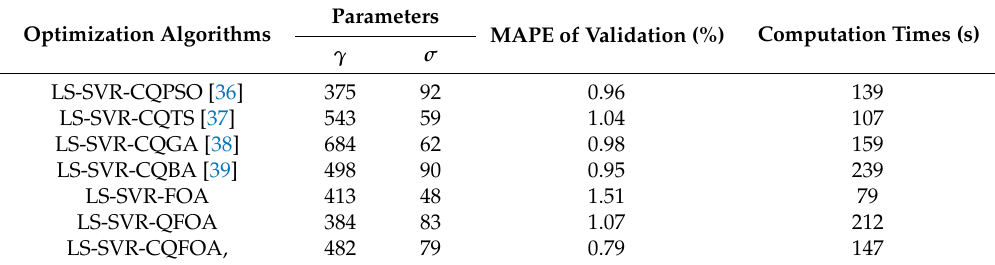
Table 6. Parameters combination of LS-SVR determined by CQFOA and other algorithms for GEFCom2014